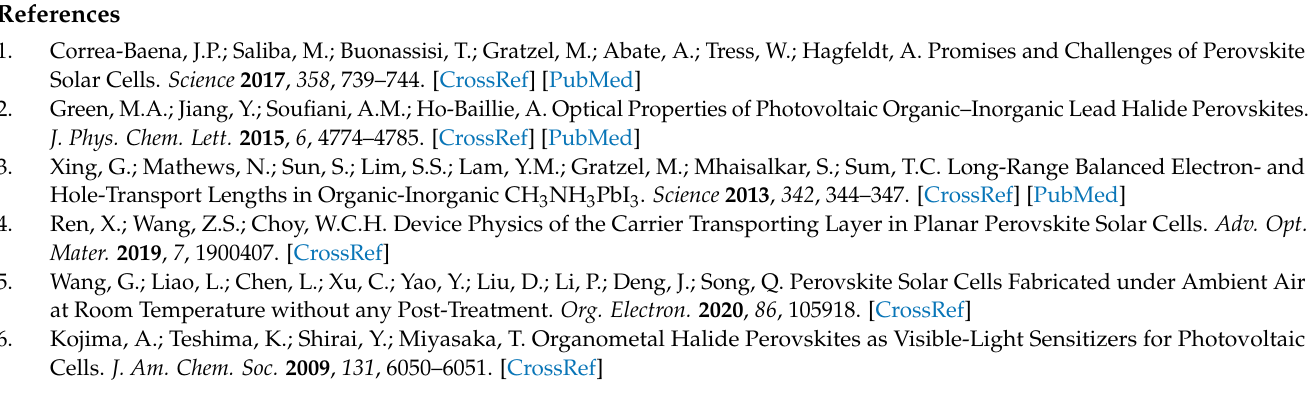
Figure S2: The EQE spectrum of D-PEDOT:PSS for each dilution device; Figure S3: AFM image of D-PEDOT:PSS for each dilution; Figure S4: The absorption data of D-PEDOT:PSS for each dilution; Figure S5: The absorption data of perovskite films deposited on different D-PEDOT:PSS